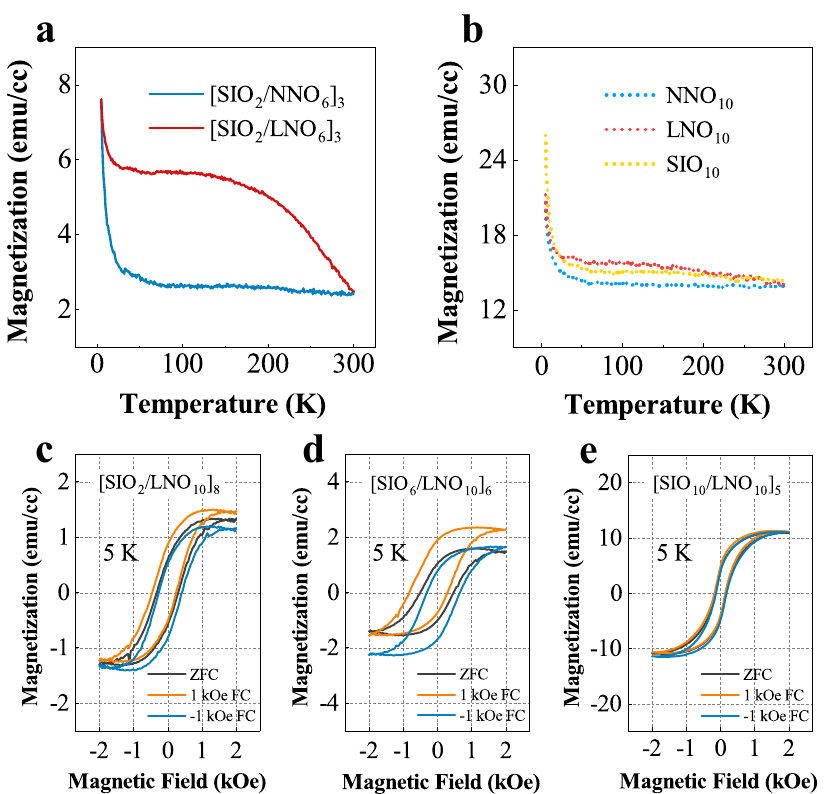
Fig. 7 Magnetic behaviors. a Temperature dependent magnetization ( M - T ) curves of the [(SrIrO 3 ) 2 /(NdNiO 3 ) 6 ] 3 superlattice (blue line), abbreviated as [SIO 2 /NNO 6 ] 3 , and [(SrIrO 3 ) 2 /(LaNiO 3 ) 6 ] 3 superlattice (red line), abbreviated as [SIO 2 /LNO 6 ] 3 superlattice, measured with 1 kOe. b M - T curves of the NNO 10 (blue dotted line), LNO 10 (red dotted line) and SIO 10 (yellow dotted line) thin fi lms, measured with 1 kOe. In-plane fi eld dependent magnetization ( M - H ) hysteresis loops of c [SIO 2 /LNO 10 ] 8 , d [SIO 6 /LNO 10 ] 6 and e [SIO 10 /LNO 10 ] 5 superlattice, respectively, measured at 5 K, after zero fi eld cooling (ZFC) and fi eld cooling (FC) with 1 and − 1 kOe, which are represented by black, orange and blue lines,